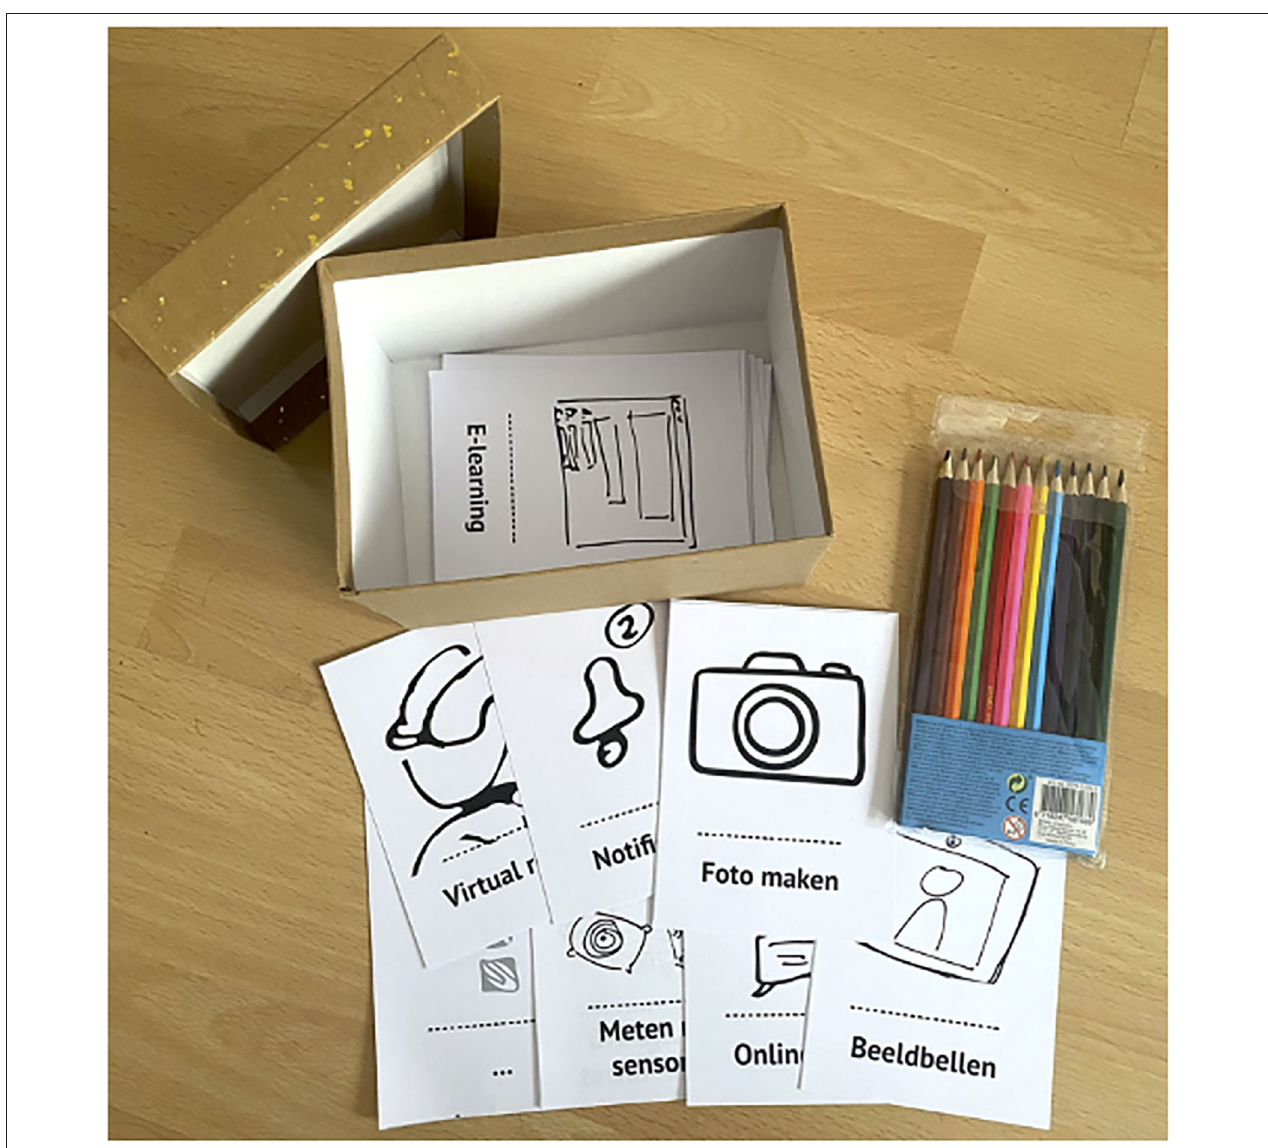
FIGURE 2 | Example of a tailor-made